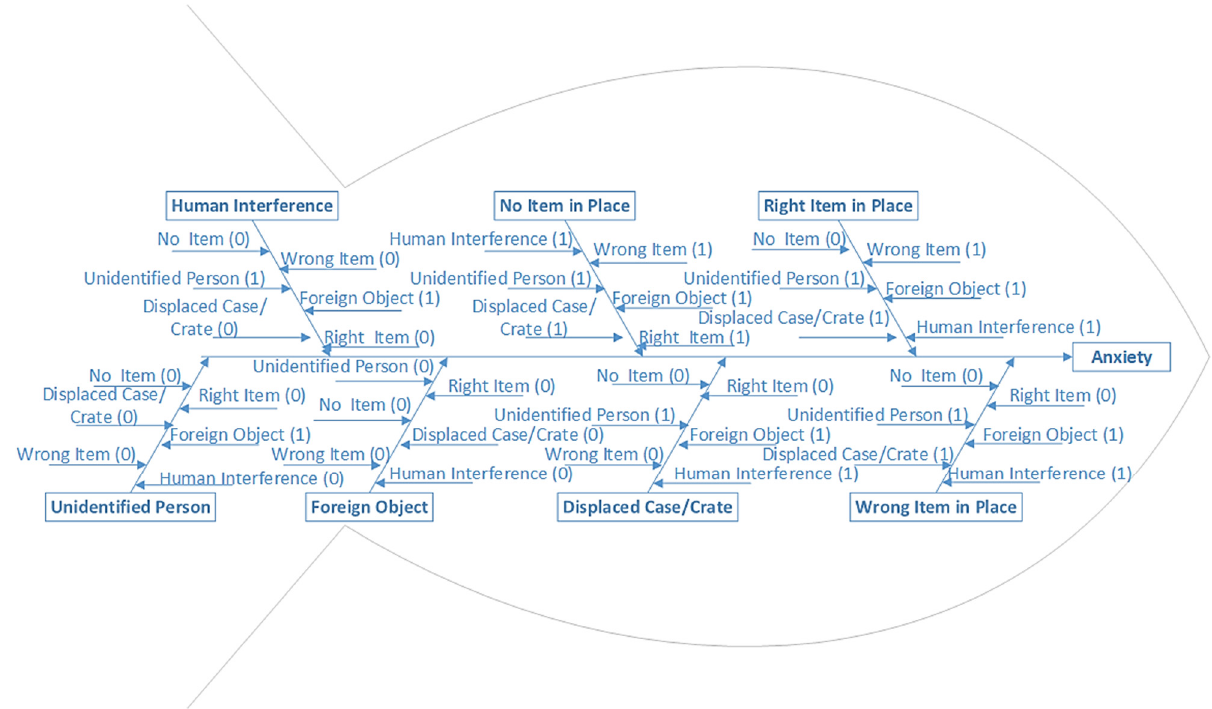
Figure 4. Calculation of index I for situations through Ishikawa. Table 3. Expected situations, their anxiety, variables, and anxiety factors.